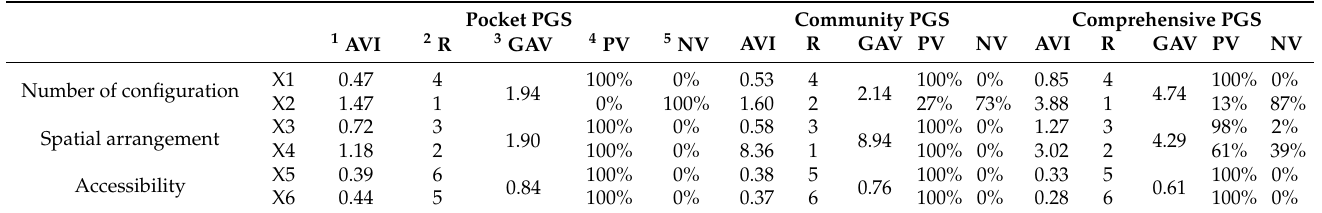
Table 10. Spatial correlation results between 3-scale PGS and coupling coordination degree (CCD).